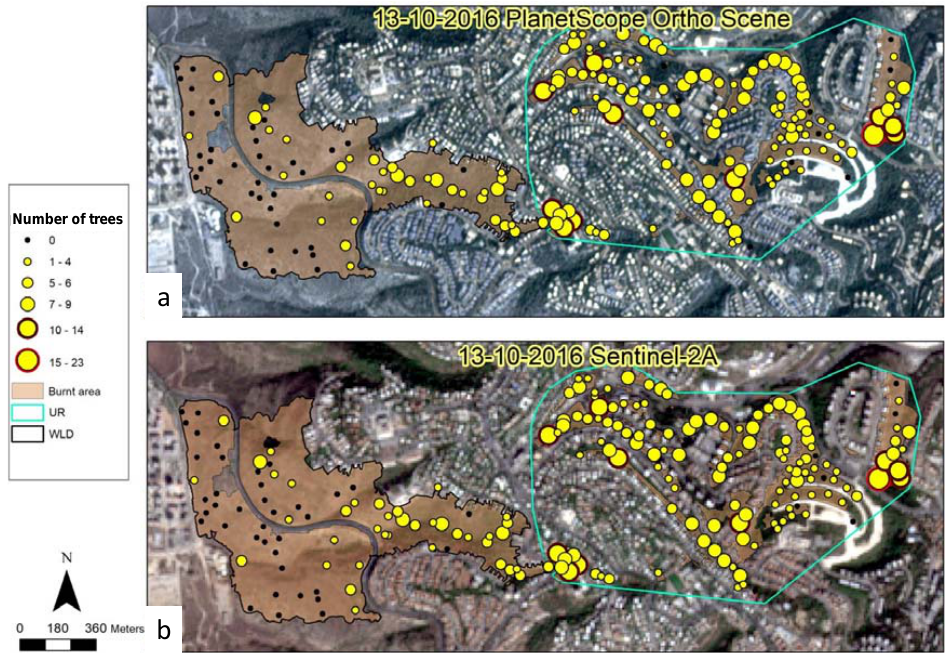
Figure 3. Number of trees counted in each (10 m × 10 m) plot in the WUI of Haifa as derived from field survey. Circle size is proportional to the number of trees in the plot. Plots are shown over false color RGB of ( a ) Planet Scope Ortho scene and an ( b ) Sentinel ‐ 2A image. Both images were taken prior the November 2016 fire (13 October 2016).